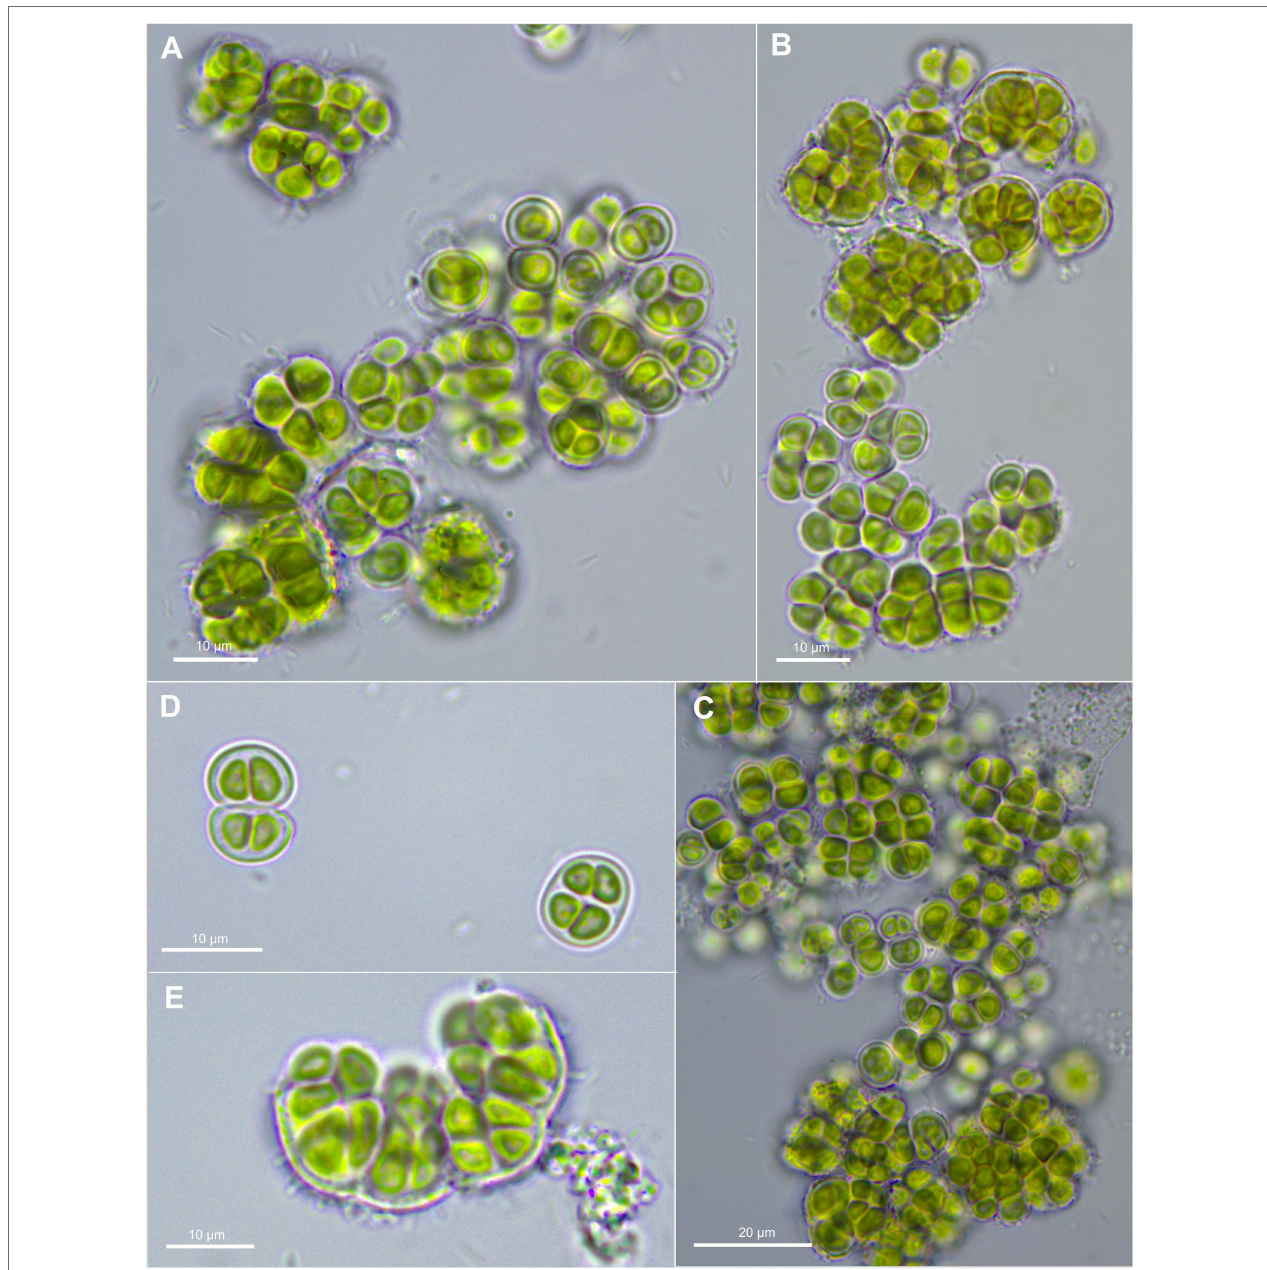
FIGURE 3 | Morphological characteristics of G. crepidinum strain LEGE06123. (A-C) show single cells and macrocolonies with thick, limited, and hyaline sheaths. (D) shows a pair of double cells (upper left corner), each surrounded by a sheath and tetrad of cells (lower right corner). (E) shows the rupture of macrocolony.